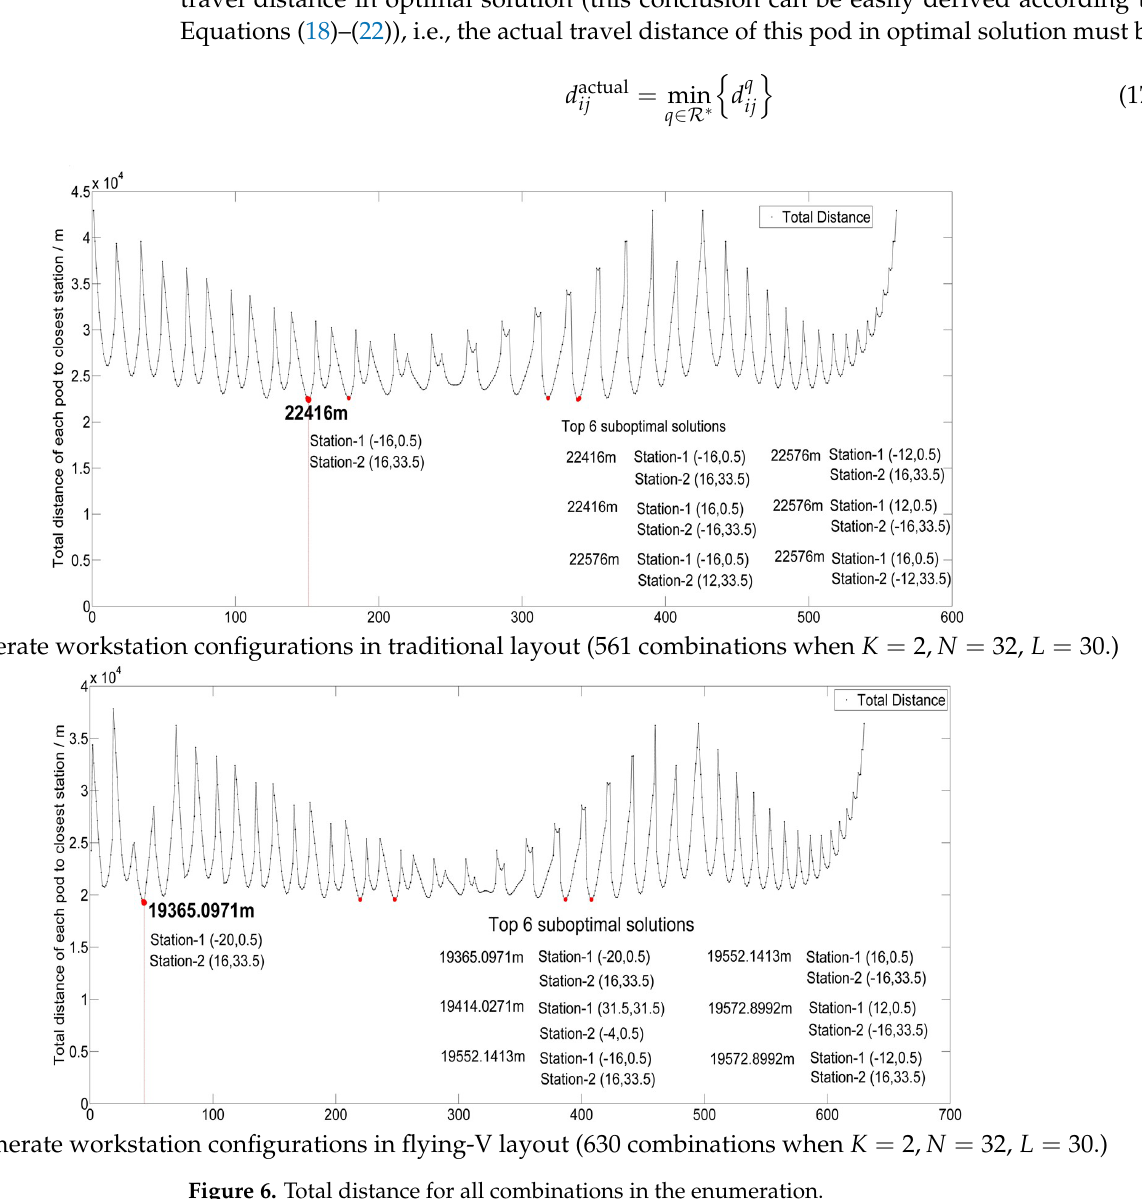
Figure 6. Total distance for all combinations in the